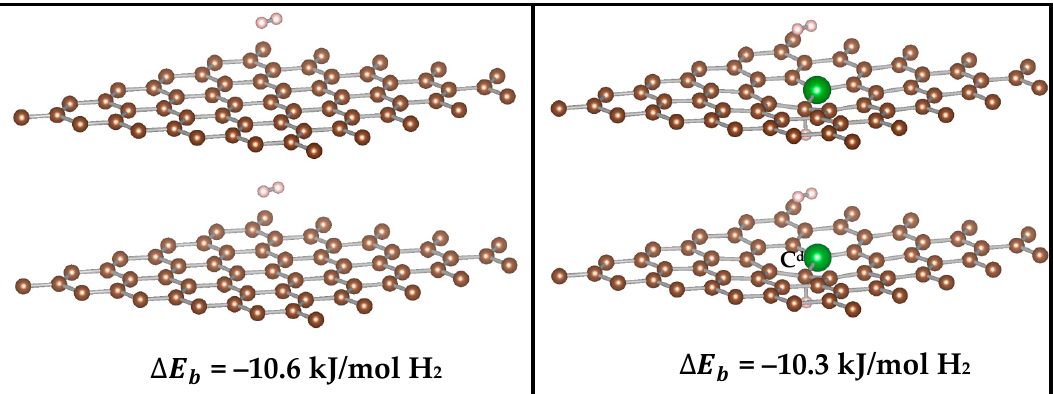
Figure 3. Position of the H 2 molecule between two monolayers of graphene (left) and 2% boron–doped graphene (right) at a distance of 7 Å along z –axis. The position and orientation of the H 2 does not change when the spacing between the surfaces is reduced from 15 Å to 7 Å (15 Å not shown), implicating long–range interactions with the second surface. The H 2 is physi-sorbed by both the top and bottom monolayers at a distance of 3.6 and 3.4 Å, respectively.